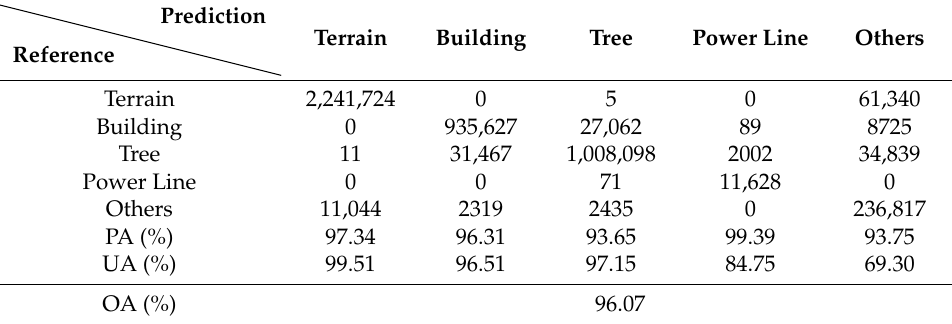
Table 3. Confusion matrix for support vector machine (SVM) classification